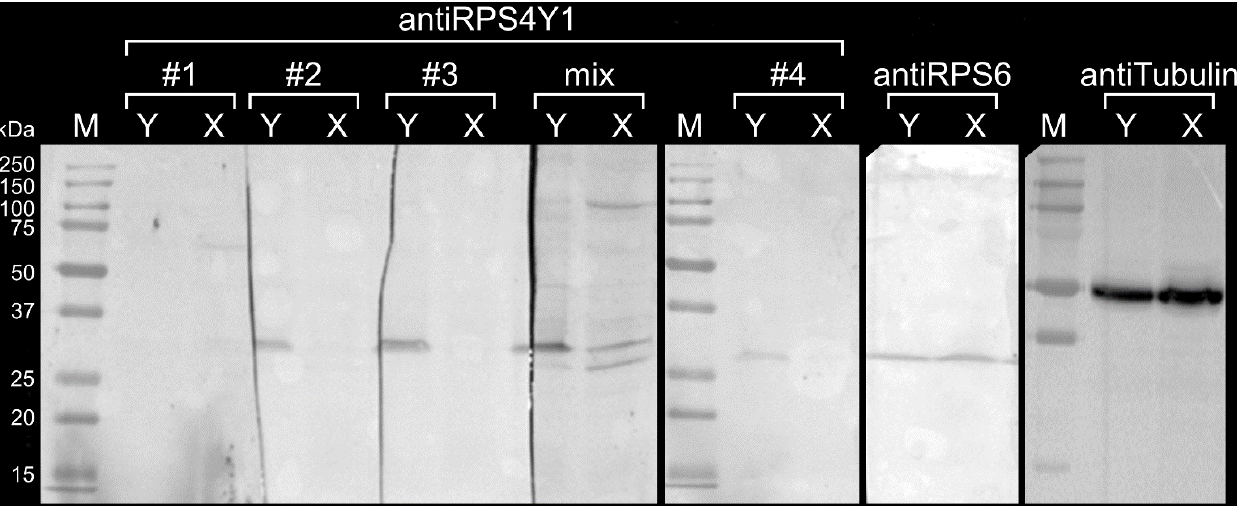
Figure 4. mRPS4Y1 antibody binding to the male RPS4Y1 protein. Representative results of SDS-PAGE and Western blotting (one out of three) performed on cell lysates of male HepG2 (Y) and female HEK293 (X) cells are showed. AntiRPS4Y1 antibodies were tested individually (#1, #2, #3, #4) and in combination (mix). AntiRPS46 and anti-tubulin antibodies were used as loading controls. The bands of the Precision Plus Protein marker (M) are indicated on the left.